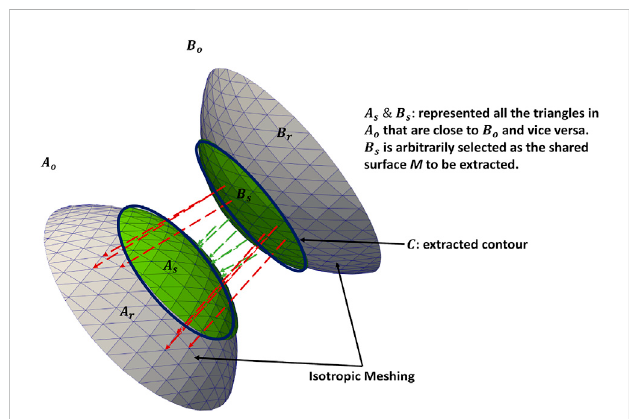
FIGURE 1 Extracting shared boundary between two meshes. The regions in green have Euclidean distances that fall within the threshold and are extractedasasharedboundaryasperstep2.Thegreenarrowsshowthe distances within the threshold for the vertices included in the shared boundary. The red arrows show distances greater than the threshold for the vertices excluded from the shared boundary. The contour is extracted from the green region as per step 4. Note: the meshes are farther apart, and the threshold is larger for visualization